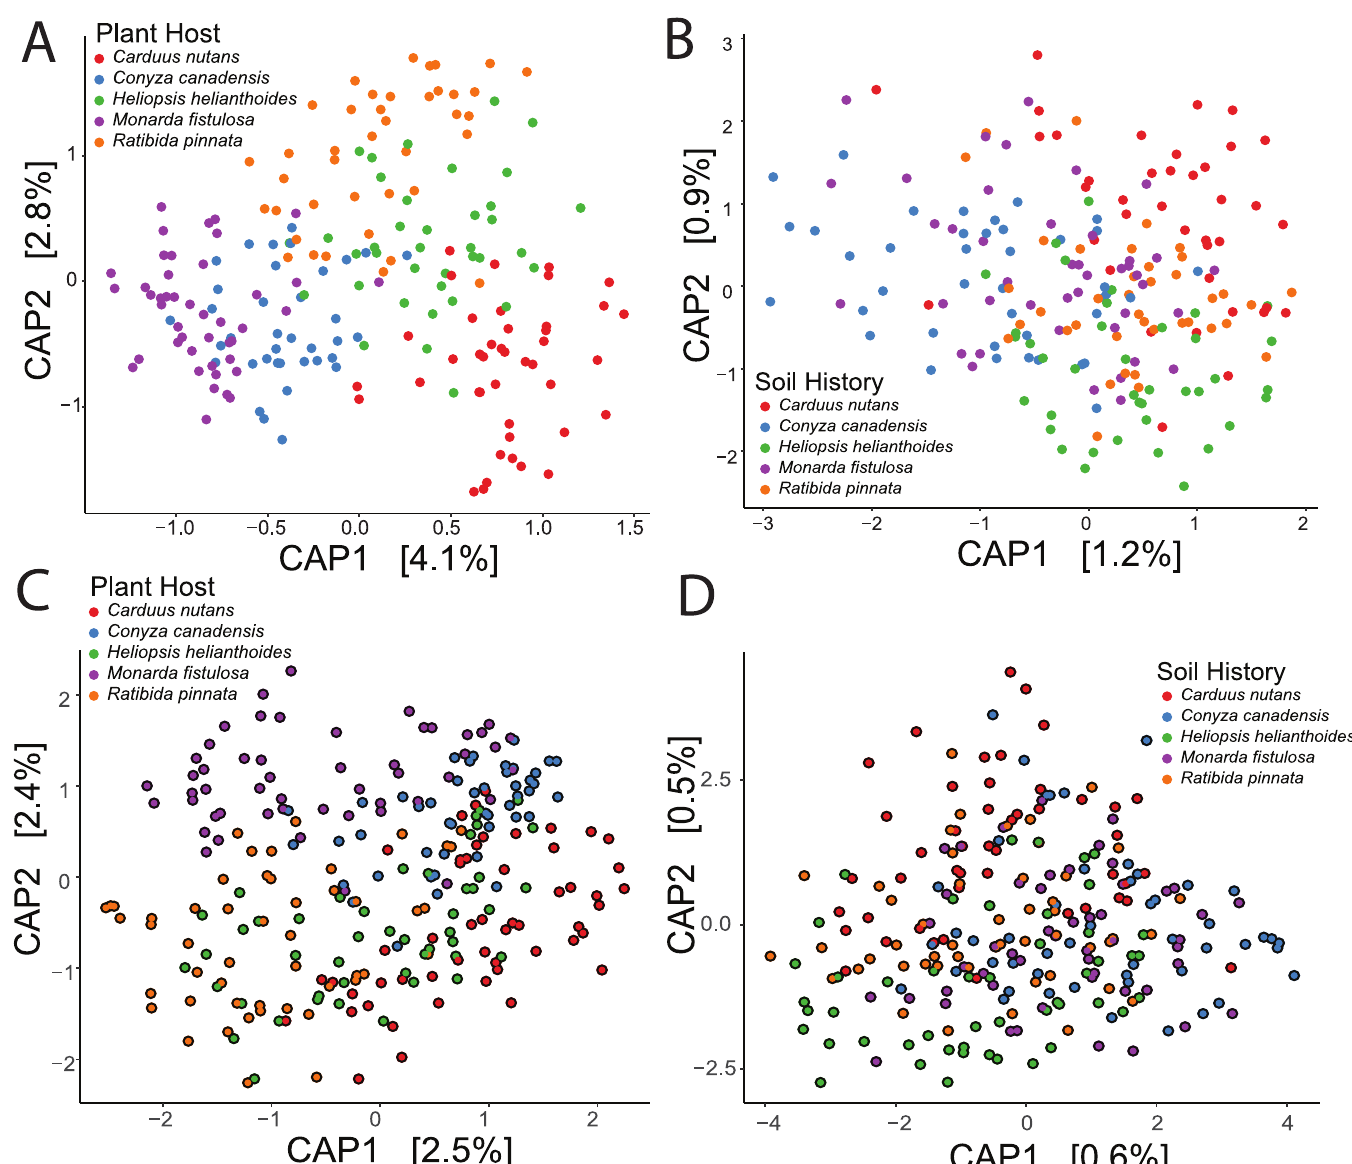
Fig 2. Plant host explains variation in root endophytic bacterial community. (A) CAP plot showing the live soil endophytic root microbiome of Carduus nutans (red), Conyza canadensis (blue), Heliopsis helianthoides (green), Monarda fistulosa (purple) and Ratibida pinnata (orange) [ADONIS p < 0.001, r 2 = 0.11, n = 201]. (B) CAP plot showing the endophytic root microbiome clustered by soil history [ADONIS p < 0.001, r 2 = 0.03, n = 201] (C) CAP plot showing both the live and autoclaved soil endophytic root microbiome clustered by plant host [ADONIS p < 0.001, r 2 = 0.07, n = 247] (D) CAP plot showing both live and autoclaved soil endophytic root microbiome separated by soil history [ADONIS p < 0.001, r 2 = 0.02, n = 247].